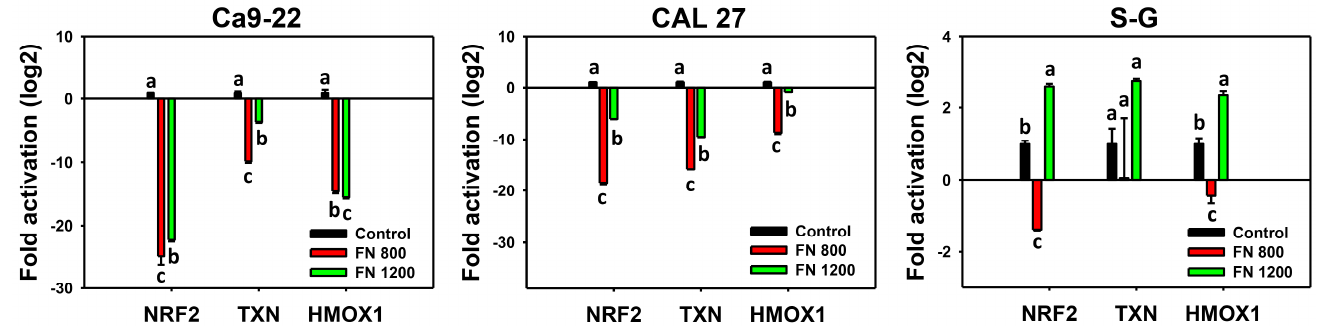
Figure 7. Fucoidan stimulates antioxidant signaling in oral cancer cells. Oral cancer (Ca9-22 and CAL 27) and non-malignant cells (S–G) were treated with fucoidan (control, 800 (FN 800), and 1200 (FN 1200) μg/mL) for 0 and 24 h for qPCR analysis. Data = mean ± SD ( n = 3 experiments). Data with non-overlapping letters reveal significant differences ( p < 0.05). In the example of Ca9-22 cells (HOMX1 gene), control, FN 800, and FN 1200, labeled with the connecting letters “a, b, and c”, have significant results, because the letters do not overlap.